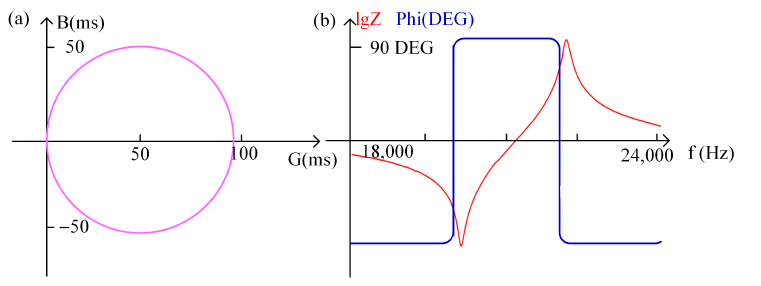
Figure 4. ( a ) Piezoelectric transducer impedance analysis admittance circle; ( b ) Piezoelectric trans- ducer impedance analysis amplitude phase curve.